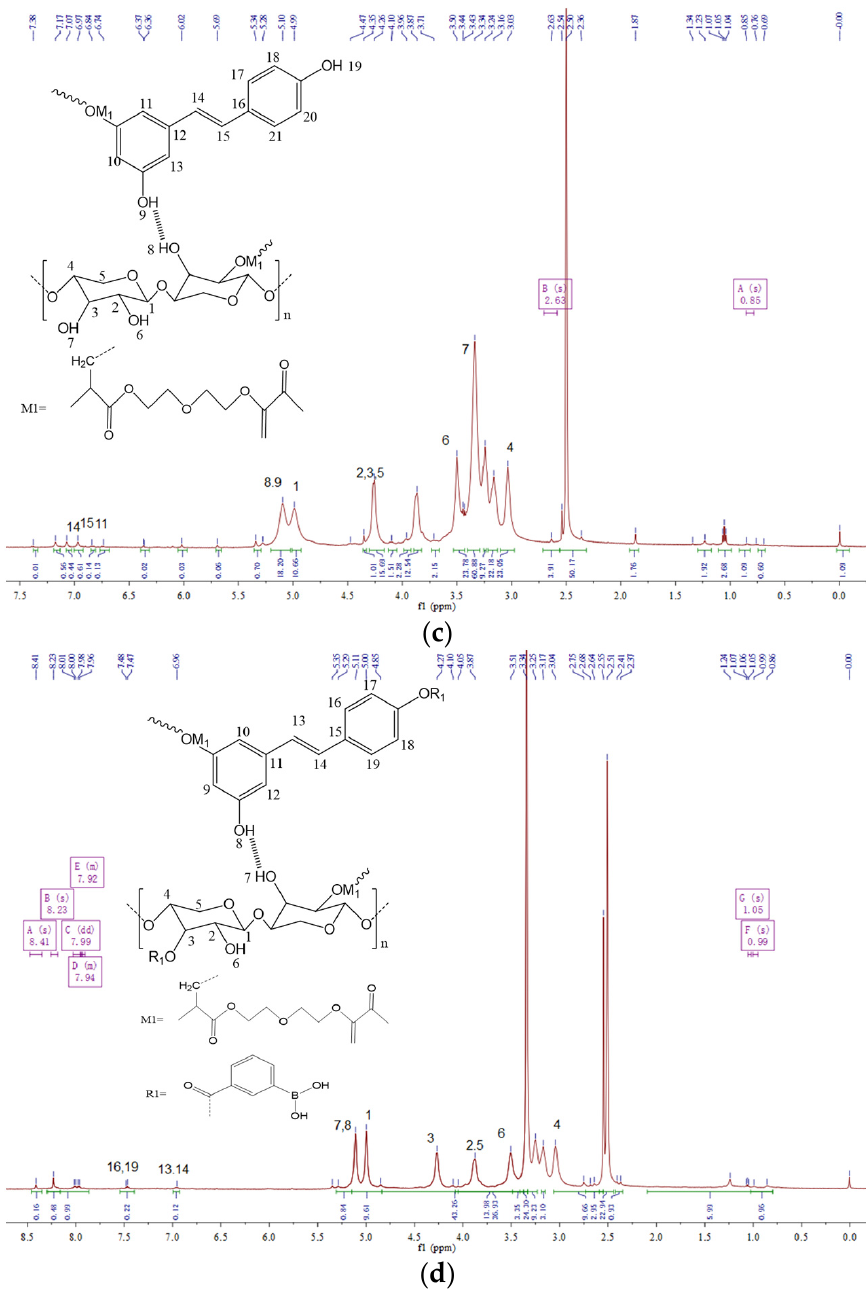
Figure 8. ( a ) 1 H NMR spectrum of BX. ( b ) 1 H NMR spectrum of Res. ( c ) 1 H NMR spectrum of BX/Res-g-EGDMA. ( d ) 1 H NMR spectrum of 3-CBA-BX/Res-g-EGDMA.